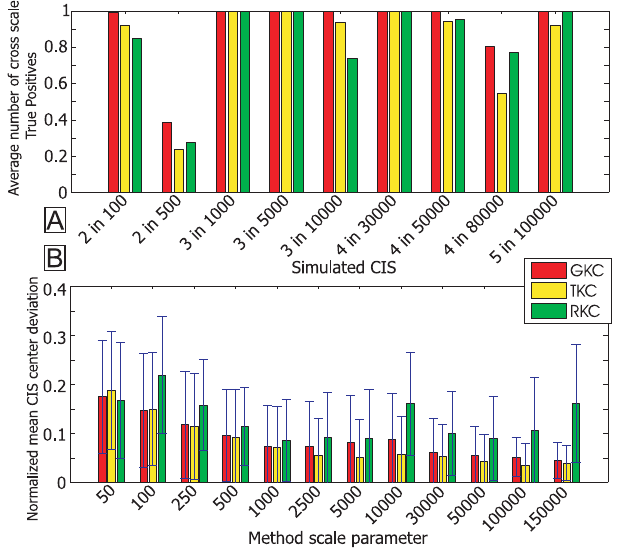
Figure 5. Results from Simulation Experiments—Cross Scale True Positives and Deviations from CIS Center (A) Average number of csTPs per artificially generated CIS. Significant errors are made for the borderline cases: the narrow CISs (500 bp), or broad CISs (80k bp) with relatively few insertions. The GKC outperforms the RKC and TKC for all simulated CISs. (B) Average deviation of the detected CIS center from the actual simulated CIS center normalized on the simulated CIS width plus the scale parameter under consideration.